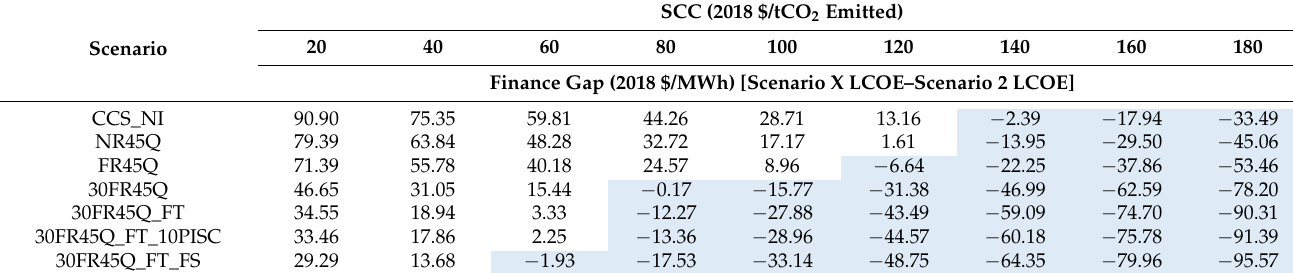
Table A8. Finance gap (2018 $/MWh) for 650-MW SubC PC scenarios.